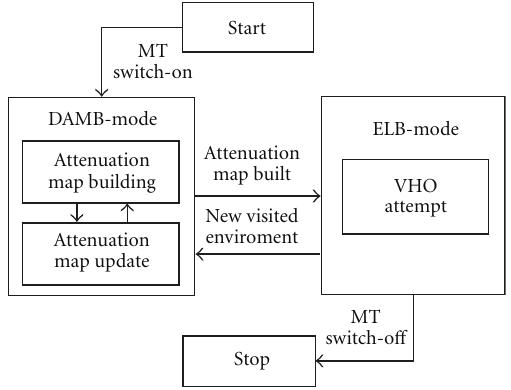
Figure 1: Finite state machine for the PLB-VHO